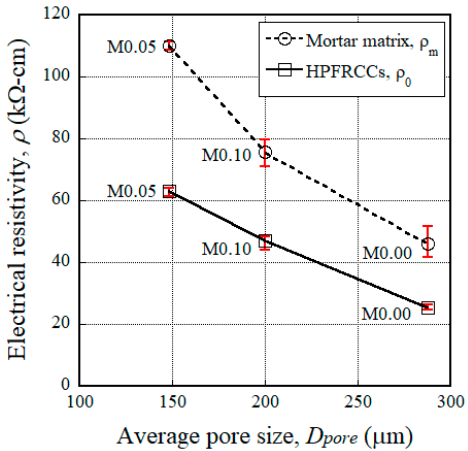
Figure 11. Correlation between the pore size and the electrical resistivity of the mortar matrix.